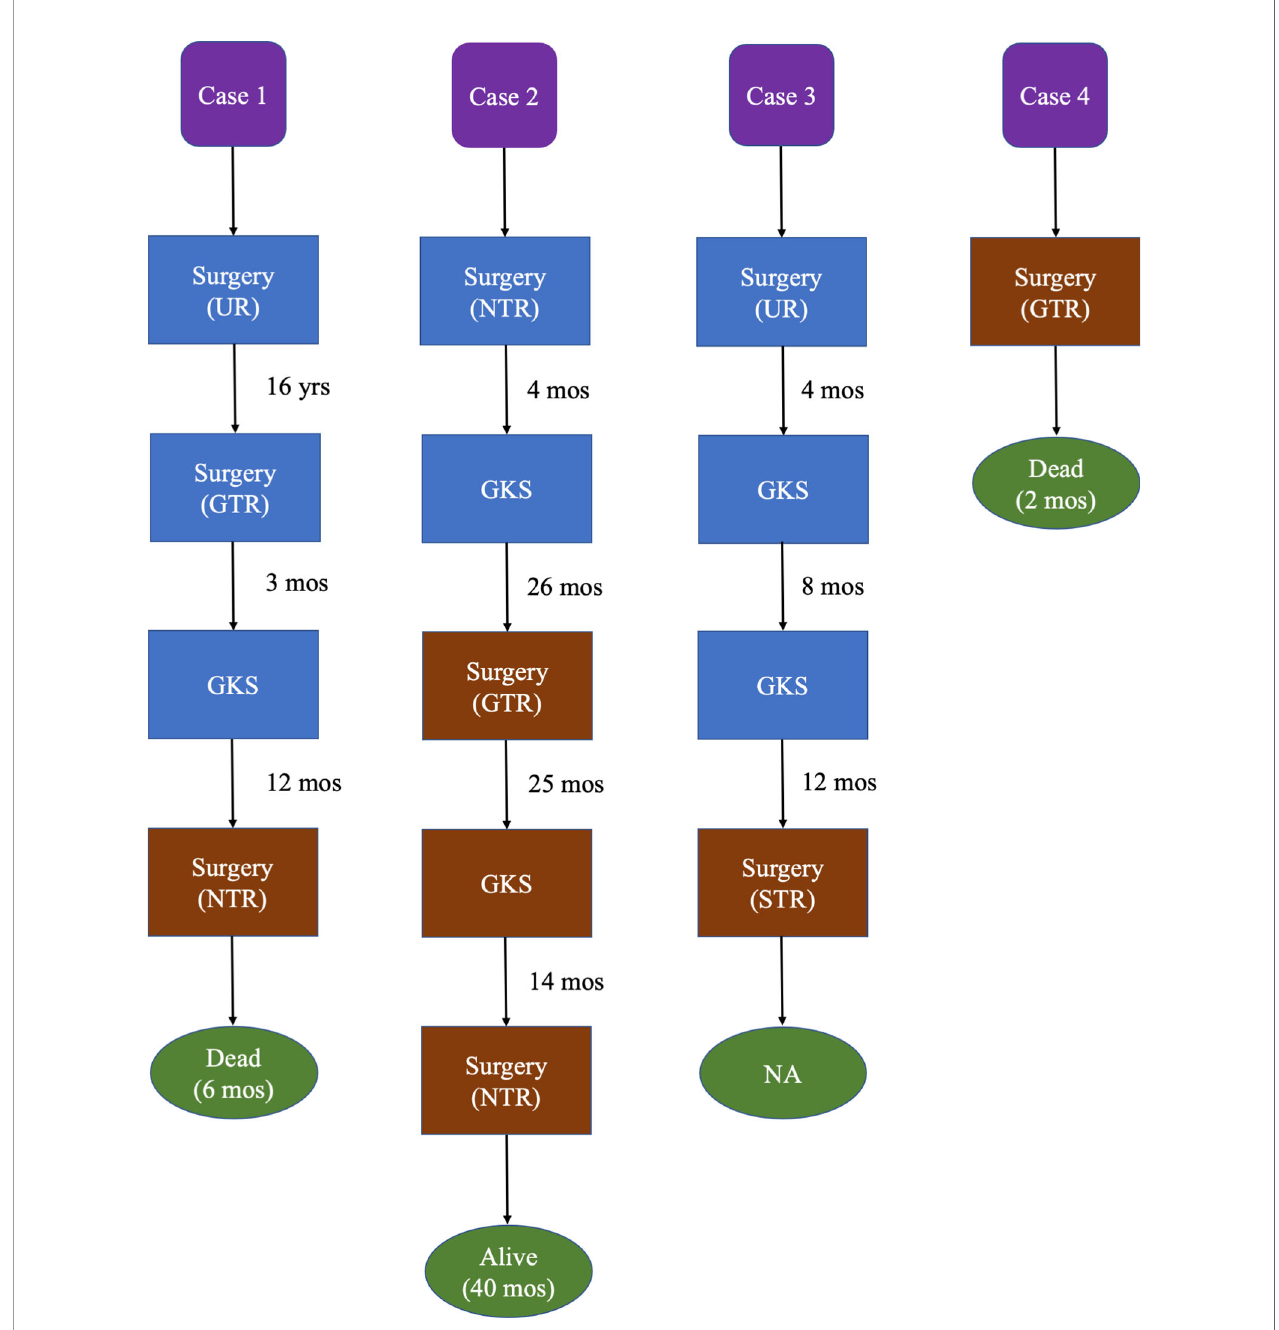
FIGURE 1 | Treatment timeline and outcome of our 4 MTVSs. Brown blocks represent having pathological con fi rmation of MTVSs. Blue blocks represent no pathological con fi rmation of MTVSs. Green ovals represent the outcome and survival time since the pathological con fi rmation of MTVSs. GKS, gamma knife radiosurgery; GTR, gross total resection; mos, months; NA, not available; NTR, near total resection; STR, subtotal resection; UR, unknown resection; yrs,